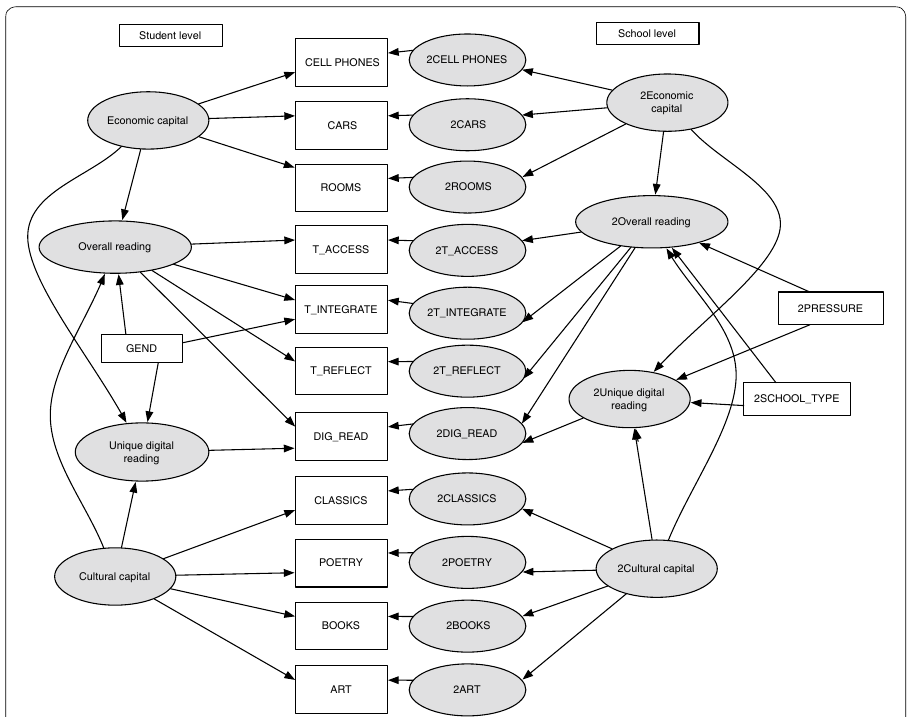
Fig. 2 The hypothesized two-level model with the student-level on the left-hand and the school-level on the right-hand